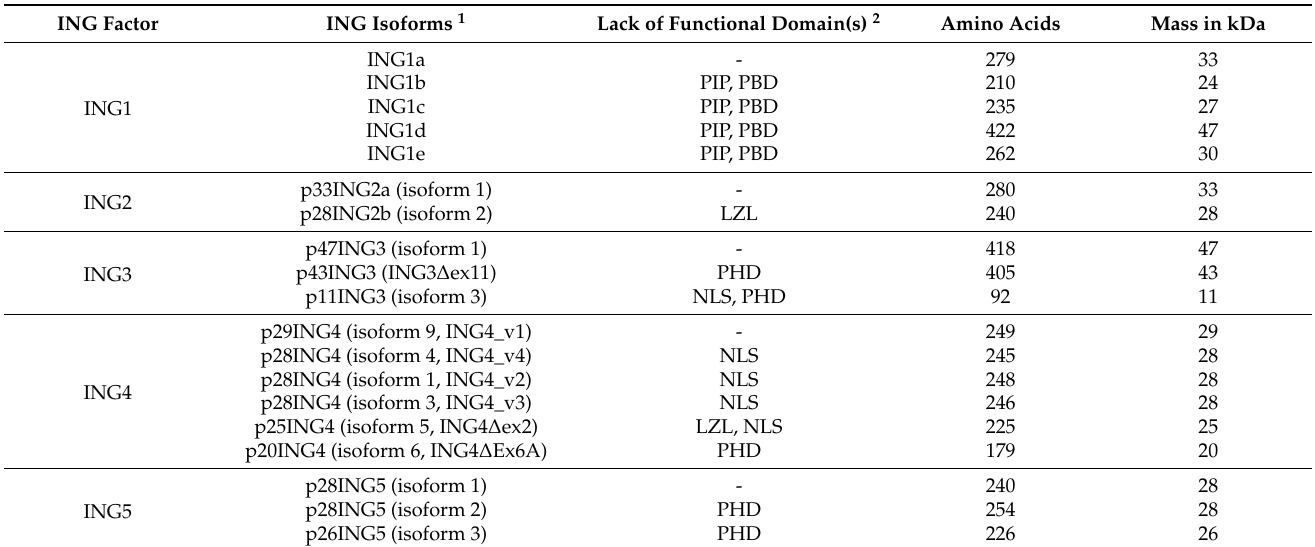
Table 1. ING alternatively spliced variants and ING alternatively used promoter usage